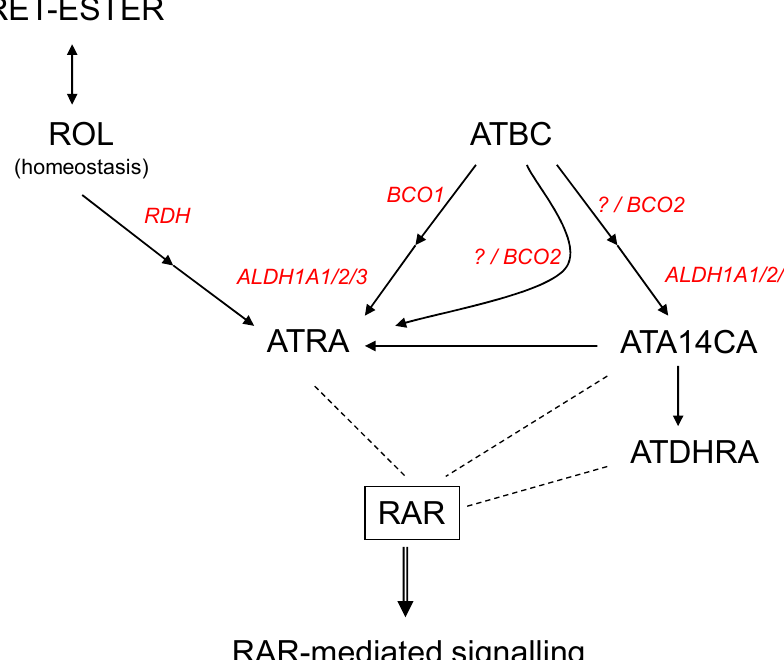
Figure 4. Mechanisms of all- trans -apo-14´-carotenoic acid (ATA14CA) mediated RAR-signalling. Scheme of retinoid and β -carotene metabolism yielding bioactive RAR-activating retinoids. Black arrows represent metabolic pathways and dashed line interaction of ligands with the nuclear hormone receptor RAR. Abbreviations: All- trans - β -carotene (ATBC), all- trans retinoic acid (ATRA), retinyl-esters (RET-ester), retinol (ROL), retinoic acid receptor (RAR), all- trans -13,14-dihydroretinoic acid (ATDHRA), retinol dehydrogenase (RDH), retinaldehyde dehydrogenase (ALDH1A1/2/3), beta-carotene oxygenase 1 (BCO1), beta-carotene oxygenase 2 (BCO2).